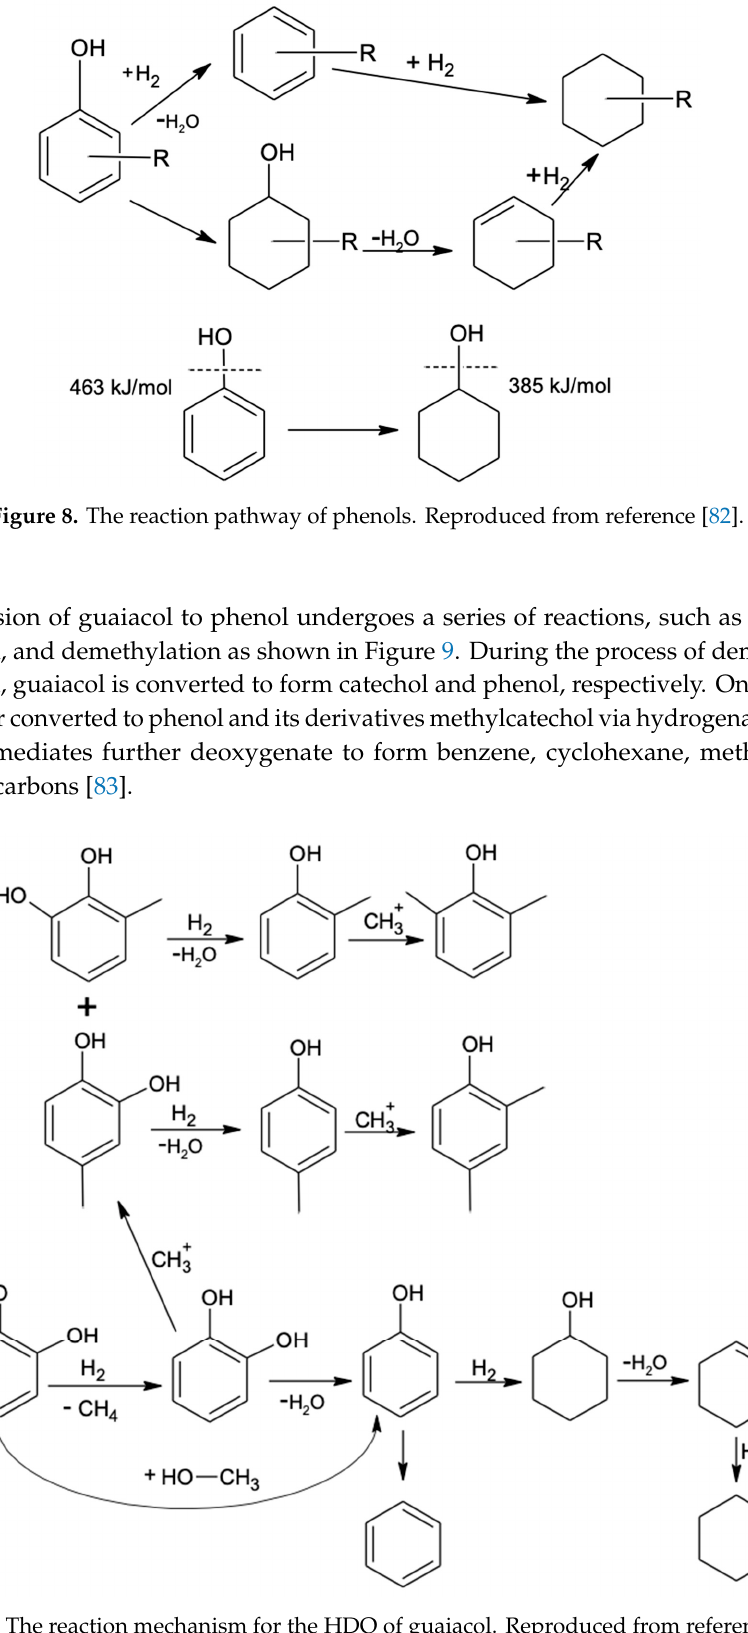
Figure 10. The reaction mechanism for the HDO of β –O–4 dimers. Reprinted from reference [84].